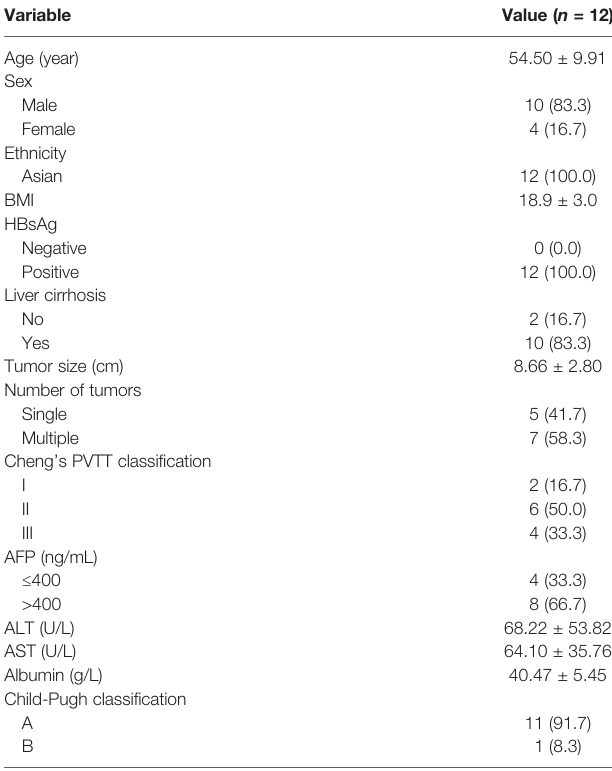
TABLE 1 | Clinicopathological variables of enrolled patients with HCC.